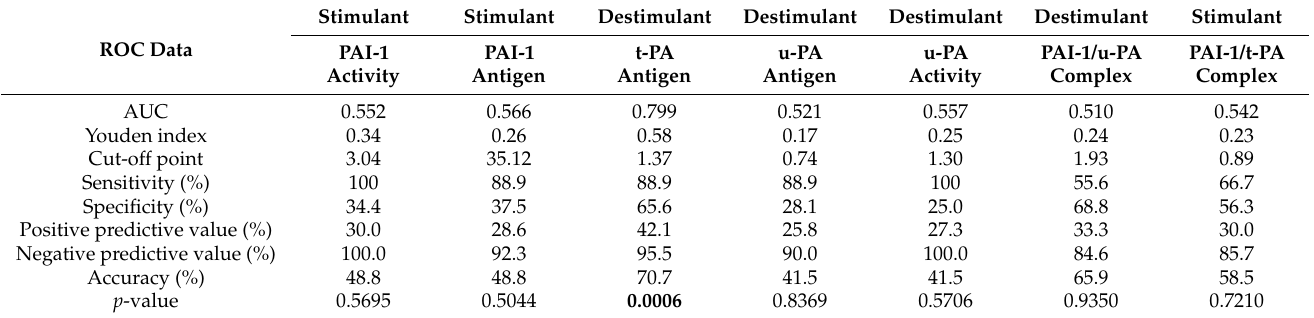
Table 4. Results of predictive accuracy for individual fibrinolytic parameters.